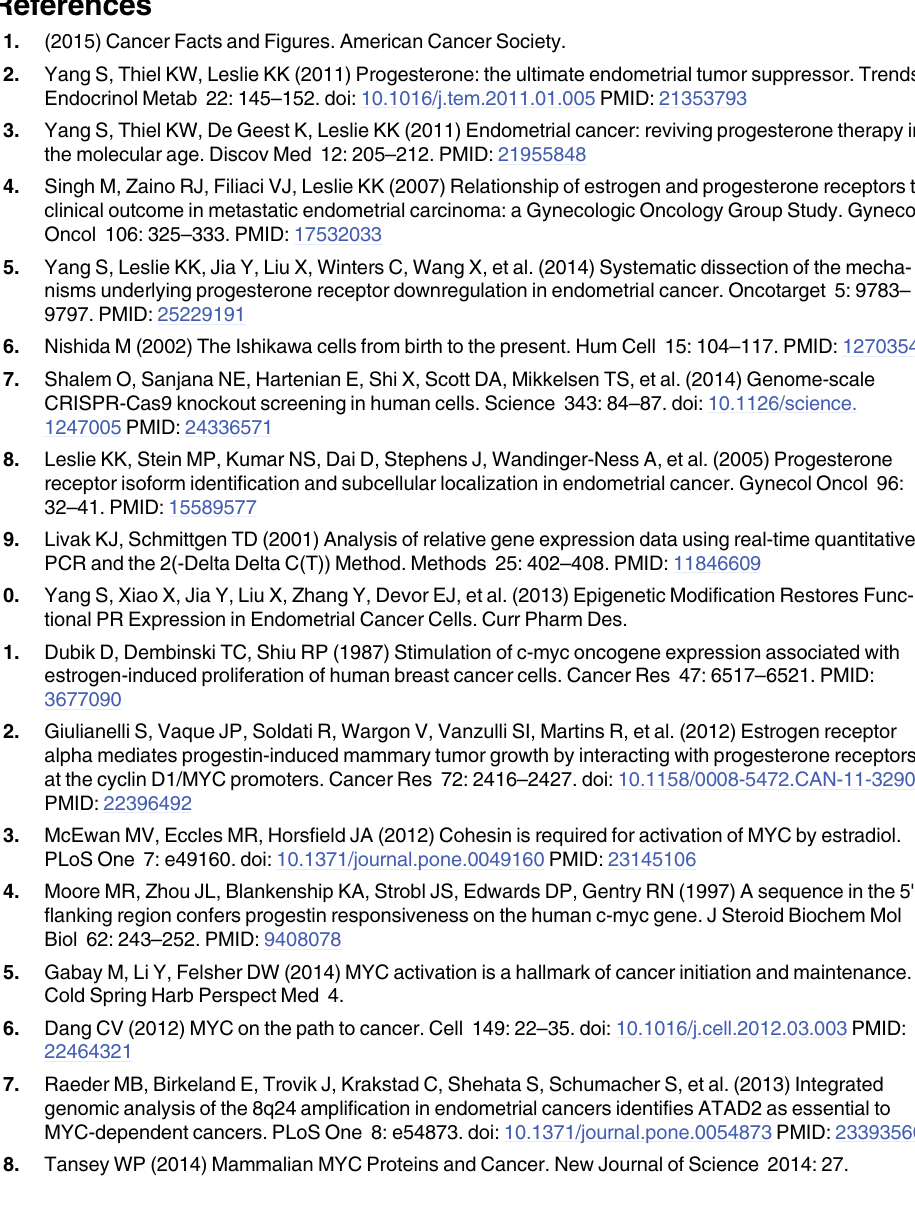
S1 Table. ESR1 sgRNA sequence and primers for real-time